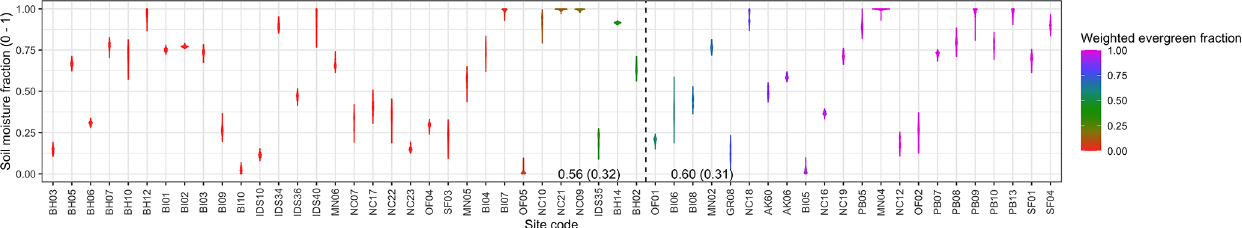
Figure A4. Site-specific relative soil moisture (0 indicates dry; 1 indicates wet) posterior estimates. Sites are sorted in order of increasing weighted evergreen